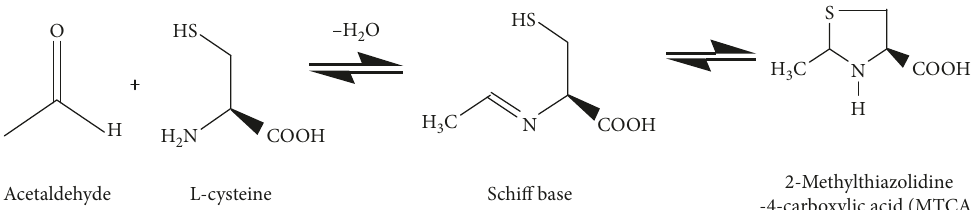
Figure 6: Chemical structural formula of L-Cys reacts with acetaldehyde to generate 2-methylthiazolidine-4-carboxylic acid